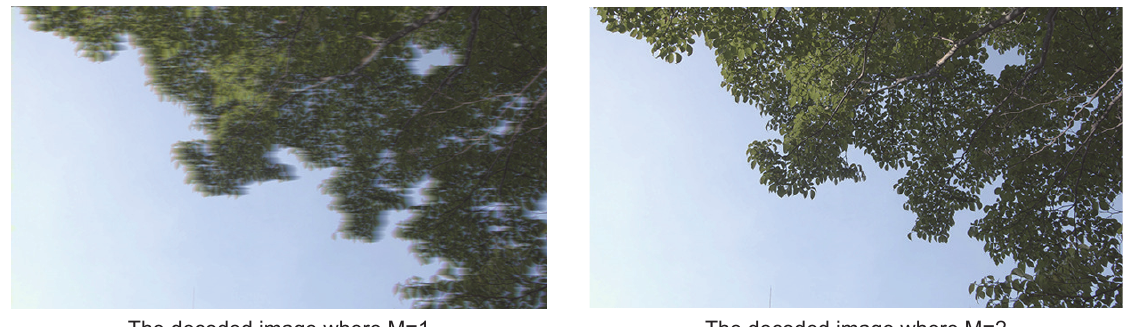
The decoded image where M=1 The decoded image where M=2 Figure 7. The decoded images when M = 1 and M = 2 using the evaluation image a) shown in Figure